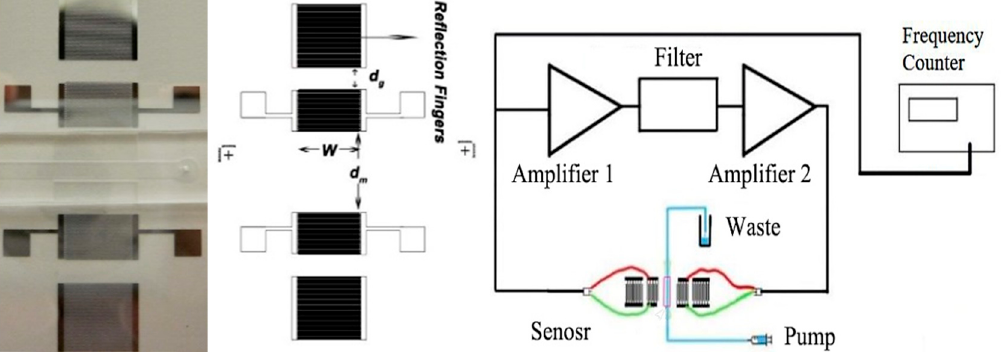
Figure 6. Fabricated two-port resonator on 90° Y-propagated ST-cut quartz wafers. Conceptual view of the oscillatory circuit system for detection. Table 2. Device parameters used for the fabrication of the Interdigital transducer (IDT) transducers. Parameters